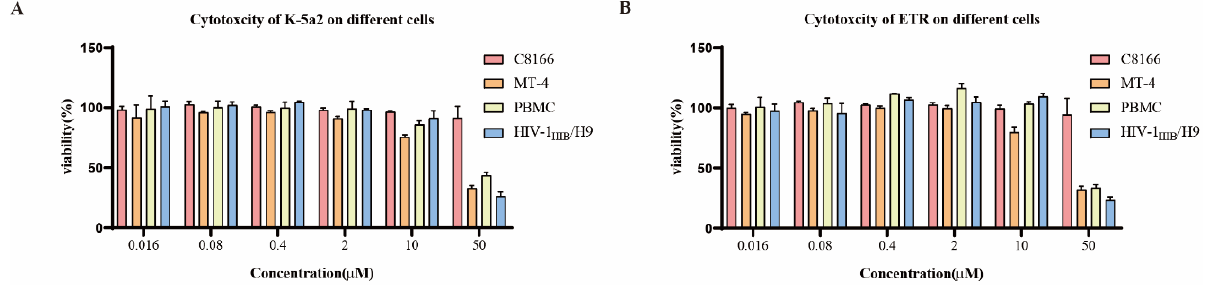
Figure 3. The cytotoxicity of K-5a2 ( A ) and ETR ( B ). The cytotoxicity of K-5a2 and ETR on C8166, MT-4, H9/HIV-1 IIIB , and PBMCs was measured by MTT assay. All data represent the mean ± standard deviation for three independent replicate experiments. Table 1. Summary of anti-HIV-1 activities of K-5a2 and ETR in cell cultures.